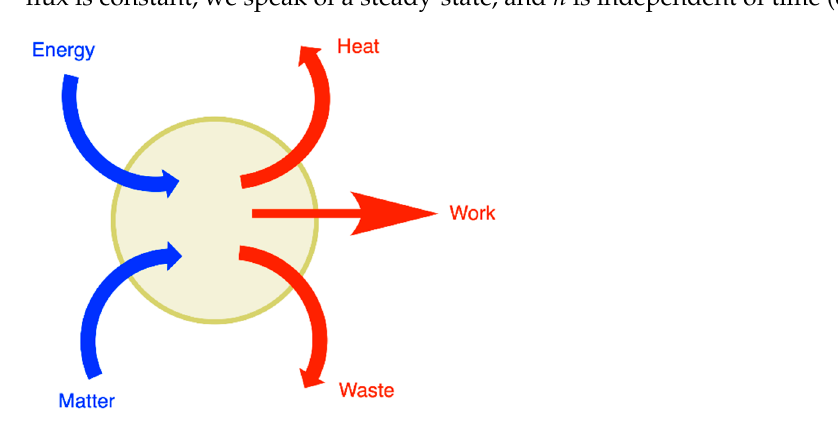
Figure 1. Living organisms are open thermodynamic systems traversed by energy and matter. The energy is dissipated as heat or converted to work. While some of these flows are vectorial (transport of a molecule across a membrane, heat transfer), others are not (chemical reactions).